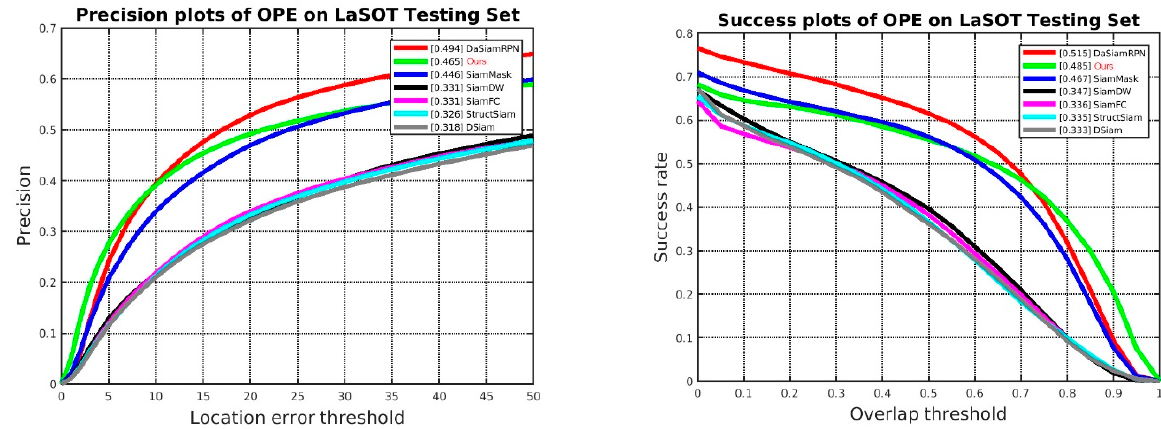
Figure 6. Comparison of properties on LaSOT testing set in terms of success and precision plots of OPE.